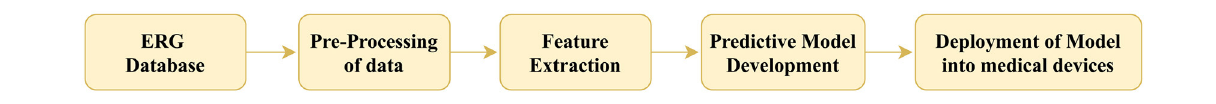
FIGURE 1 | Machine learning workflow using ERG signals. ERG Database: the ERG database contains the input ERG data used to train the predictive model. Pre-processing of data: this step ensures data quality by transforming the data to a common baseline, accounting for missing data, and handling outliers. Feature extraction: mathematical operations are performed on the data to extract features/parameters that indicate functional deficits in the eye. Predictive Model Development: algorithms can determine trends and patterns in data from statistical analysis of extracted features during training; these models can predict either class or value from the input data are called classifier and regression models, respectively. Deployment of Model into medical devices: successful predictive models can be included with ERG testing devices to provide real-time prognosis and